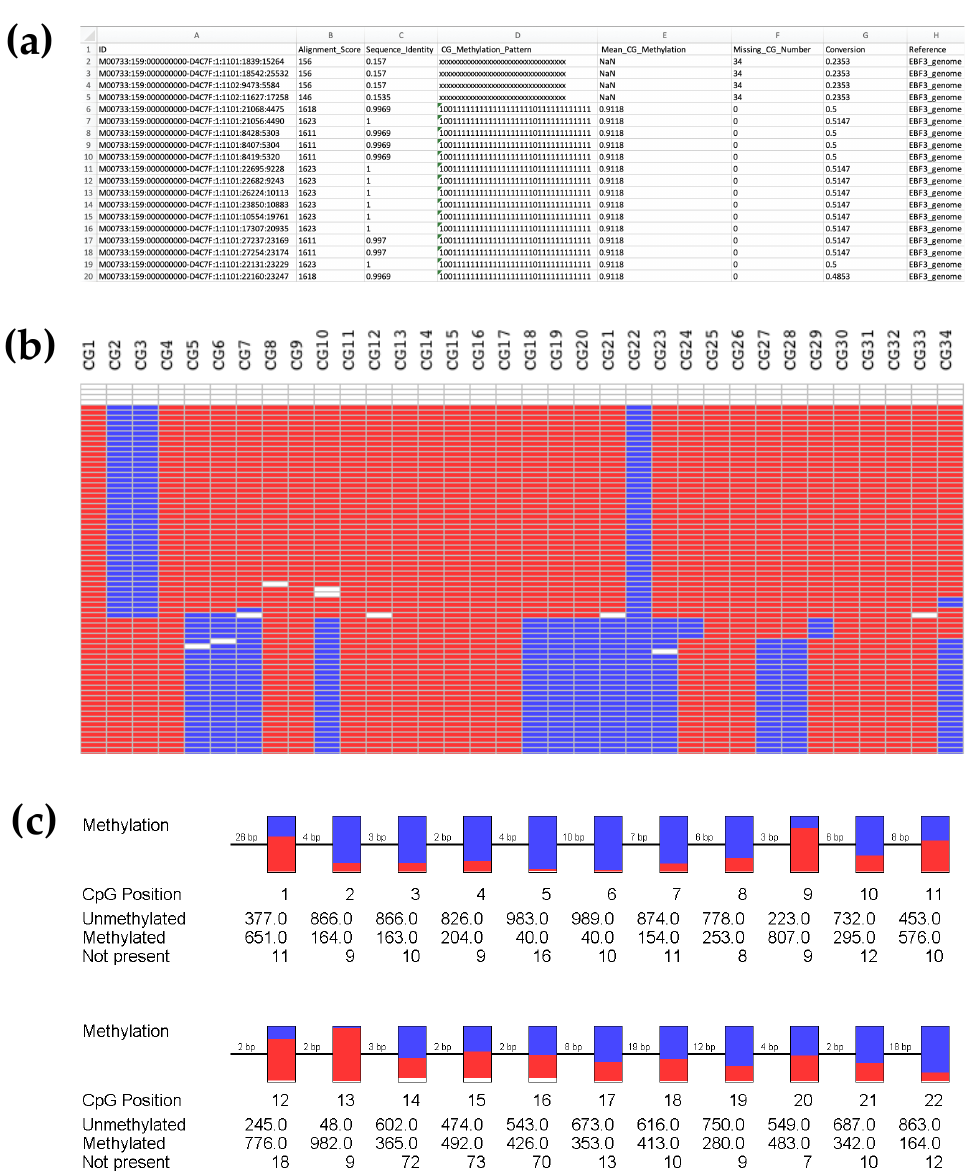
Figure A2. BiQ Analyzer HT processing during the analysis of targeted methylation sequencing data. ( a ) Example output results.tsv file (opened in Microsoft Excel) summarizing the results of sequence alignment for a particular demultiplexed sample with 34 CpG sites interrogated in BiQ Analyzer HT. This provides all information for a particular read following alignment and calculates multiple parameters to assess the success of read alignment. The binary methylation output